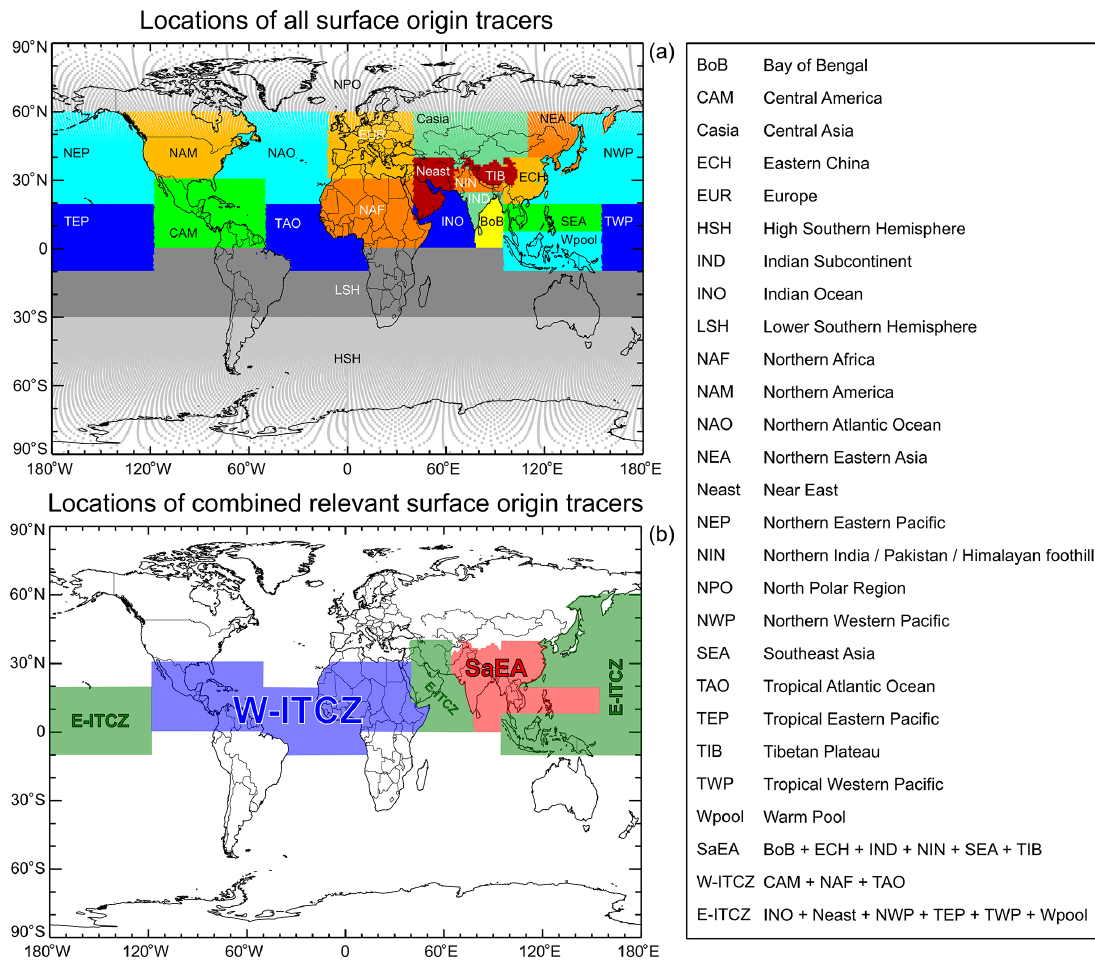
Figure 2. World map depicting the boundaries of CLaMS’s 24 surface origin tracers (a) and three surface origin tracers combining several tracers from regions of significant ( > 90%) impact on the WISE measurements (b) . The tracer names corresponding to their abbreviations are listed next to the maps. Also included in the list are the tracers of combined regions (see Sect. 3.1.2).